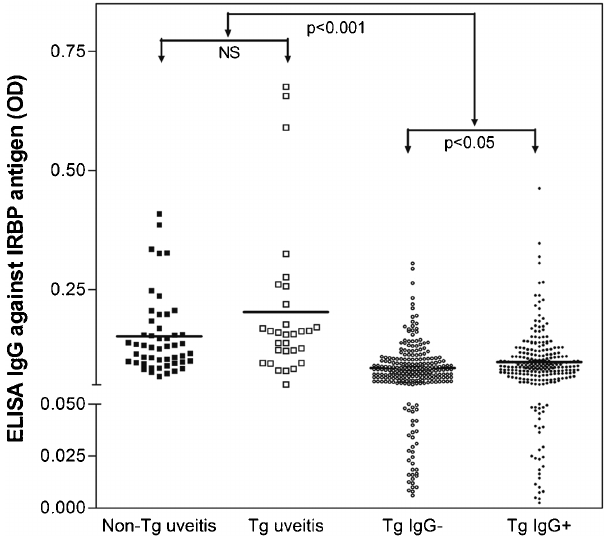
Figure 3 - Antibodies against bovine interphotoreceptor reti- noid-binding protein (IRBP) antigen in selected patients. Non-Tg uveitis: samples from patients with uveitis other than toxoplas- mosis (n=50; see Methods). Tg uveitis: samples from Toxoplasma uveitis patients (n=30). Tg IgG-: samples from patients who were seronegative for T. gondii (n=250). Tg IgG + : samples from patients who were seropositive for T. gondii . Bars represent mean values. The y-axis was interrupted at cut-off using the mean minus 2 SD of samples from all uveitis